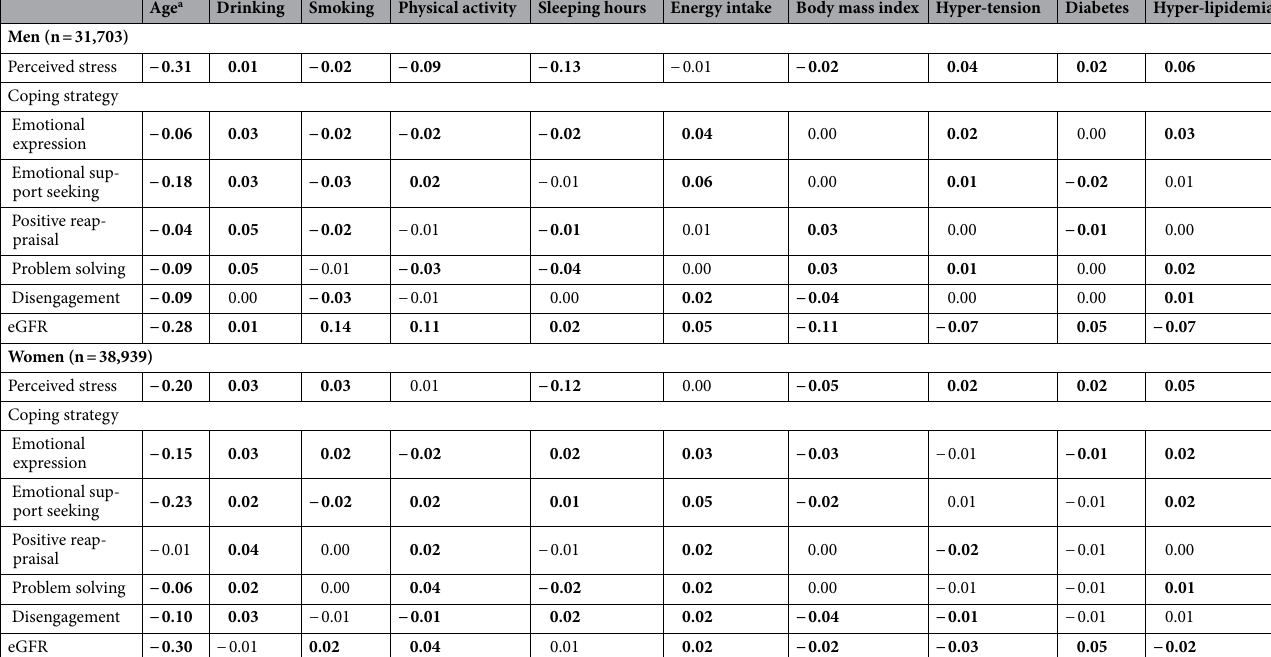
Table 2. Age-adjusted Spearman’s rank correlation coefficients of perceived stress, coping strategies, and eGFR with covariates by gender. Categorical variables (perceived stress, coping strategies, drinking, and smoking) were converted to ordinal variables. Bold font represents P < 0.05. a Without adjustment.